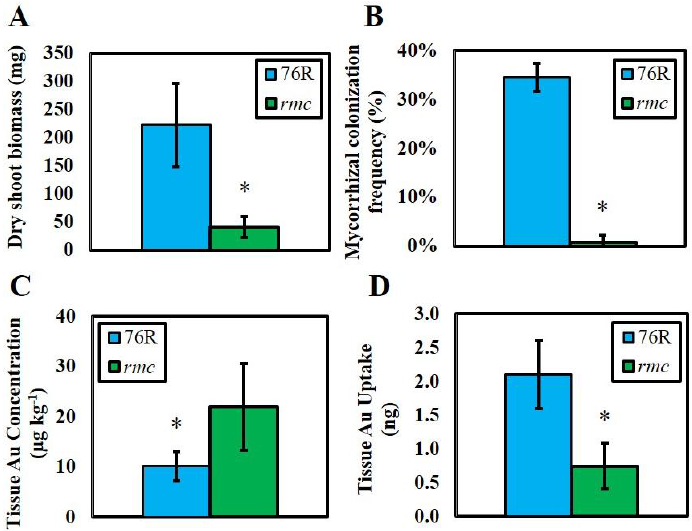
Figure 1. Dry shoot biomass ( A ); mycorrhizal colonization frequency ( B ); shoot Au concentrations ( C ); and shoot Au uptake ( D ) measured in 76R and rmc tomato plants. Error bars represent standard deviation. The * indicates a significant difference at α ≤ 0.01 as determined by a either a 2-sided T -test (concentration and uptake) or a Mann-Whitney U -test (biomass and colonization).